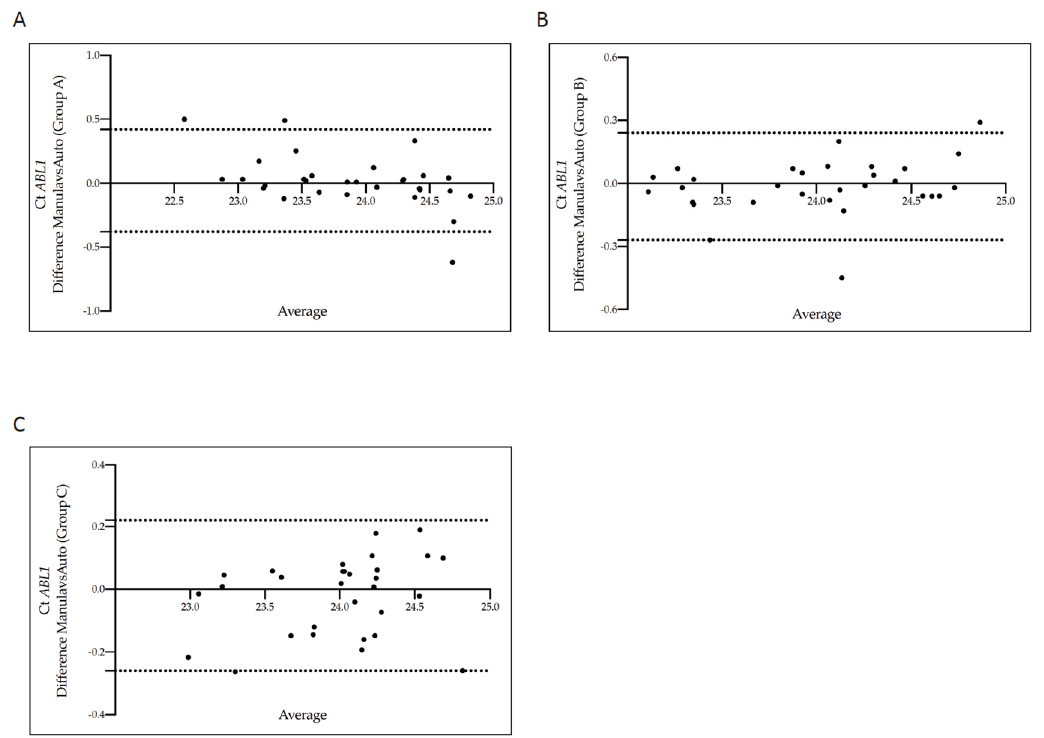
Figure 6. Bland–Altman showing the concordance of the ABL1 Cycle threshold values measured in matched samples counted by the manual and the automatic absolute cell-counting assays. Paired measurements of ABL1 Ct value were combined for patients stratified into three groups, each consisting of 30 individuals: Group A (10% > BCR-ABL1/ABL1 IS > 1%) ( A ), Group B (1% > BCR-ABL1/ABL1 IS > 0.1%) ( B ), and Group C (0.1% > BCR-ABL1/ABL1 IS > 0.01%) ( C ). The graph is plotted on the XY axis where X depicts the difference of the two measurements, and the Y-axis shows the mean of the two measurements. Horizontal lines are drawn at the mean difference between the two counting methods and the upper and lower limits of agreement. The 95% confidence intervals are shown for the mean and the upper and lower limits of agreement.